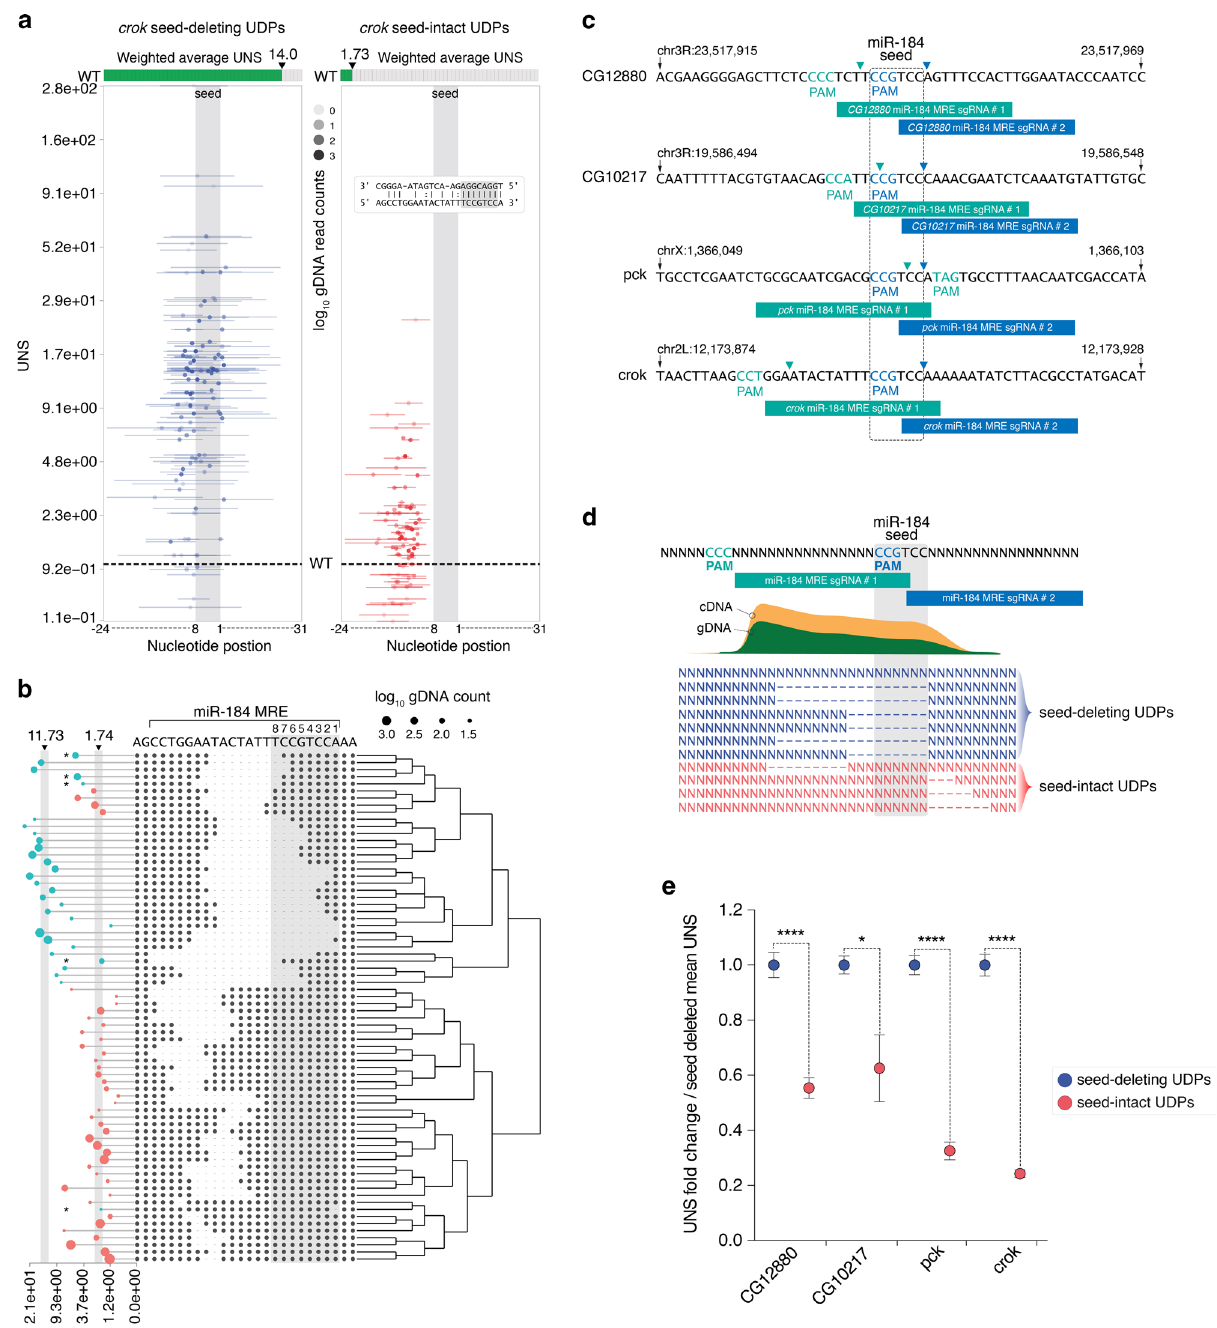
Fig. 7 Functional dissection of MRE sequence determinants. a Mapping of the complete UDP repertoire across the crok ROI (beginning and end coordinates of the deletion peaks) shows deletions patterns (x axis, line = UDP span, dot = center), UNS (y axis) and sequencing depth (transparency). UDPs are partitioned relative to their coverage of the extended seed region ( blue = seed deletion; red = seed intact). UNS values for the ‘ seed deletion ’ group are signi fi cantly higher than the ‘ seed intact ’ group ( t -test, P < 0.0001). Top meter indicates average UNS values for each group weighted by UDP sequencing depth ( green ). b High resolution analysis of crok UDP sets restricted to the miR-184 MRE region (nt. 1 – 22). Dendrogram showing hierarchical clustering of UDPs based on their deletion footprint ( dashed line ) is displayed along with corresponding UNS values (circle and lines horizontal plot). Scores are scaled by sequencing depth (size of circle ) and coloured depending on UDP coverage of the extended seed region ( teal = seed deletion; red orange = seed intact; * = UDP affecting only seed distal nucleotides). c – e Analysis of sequence determinants underlying top ranking MREs from GenERA screen. To increase UDP complexity at each targeted locus, a second batch of sgRNAs was designed ( blue ) in addition to the ones used for the GenERA screen ( green ) ( c ). The identity of each protospacer (box), Cas9 cut site (arrow head) and PAM sequence are shown. d Diagrammatic representation of the computational approach used to demultiplex the ensuing UDP repertoire into seed-deleting ( dark blue ) and seed-intact ( red ) classes. e Seed-intact UDPs consistently generate lower UNS values compared to seed-deleting UDPs (Error bar = SEM, Mann-Whitney test, ****P < 0.0001, *P < 0.05)